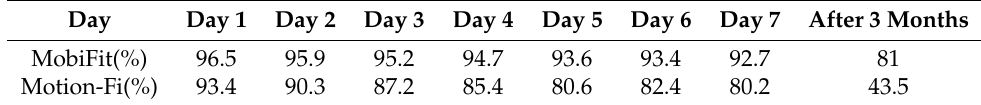
Table 4. Classification permanence of MobiFit, Motion-Fi